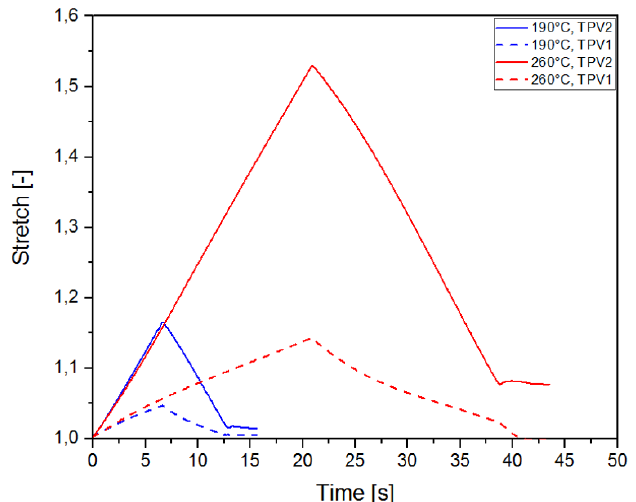
Figure 13. Stretch-time evolution for each TPV overmoulded at 190 ◦ C and 260 ◦ C, in the case of mechanical